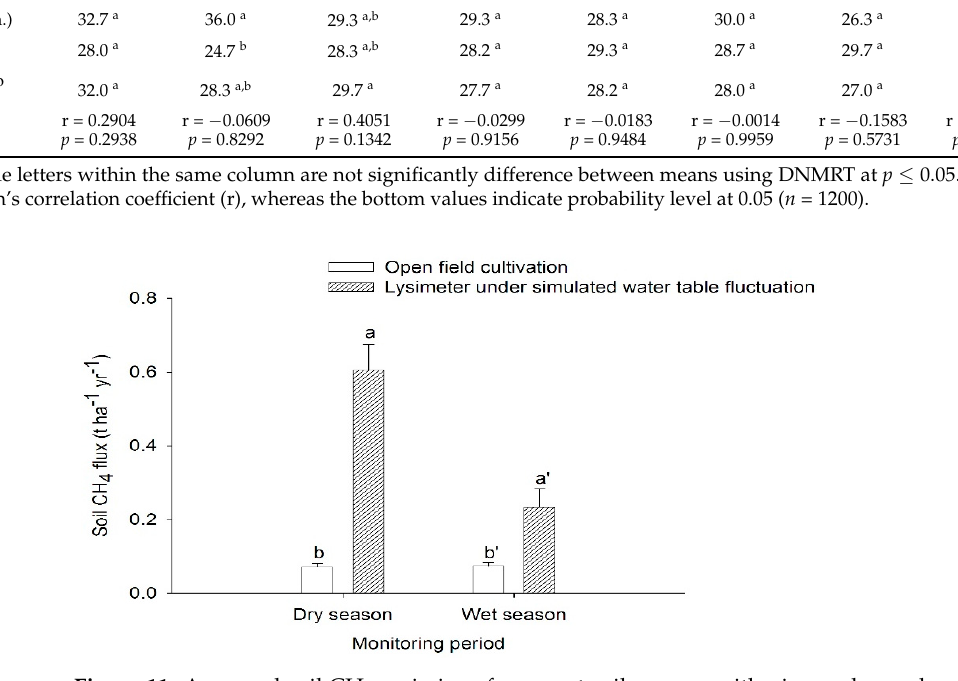
Figure 11. Averaged soil CH 4 emissions from peat soils grown with pineapples under open field cultivation system and lysimeters subjected to water table fluctuation in the dry and wet seasons. Error bars represent standard error and soil mean fluxes with different letters and noted by prime are significantly different using DNMRT at p ≤ 0.05.